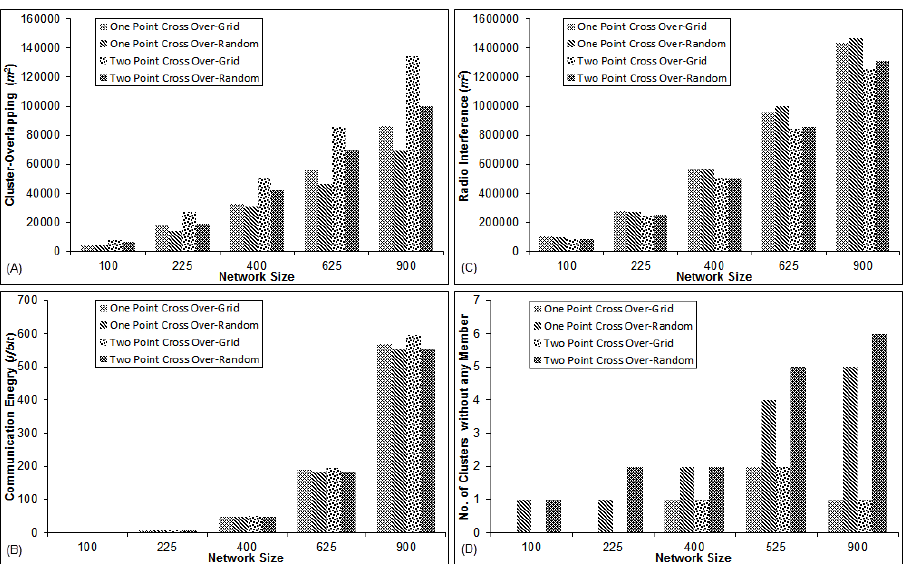
Figure 3. Cluster-overlapping (A), communication energy (B), radio interference (C), and no. of clusters without any member (D) versus network sizes for different crossover methods.